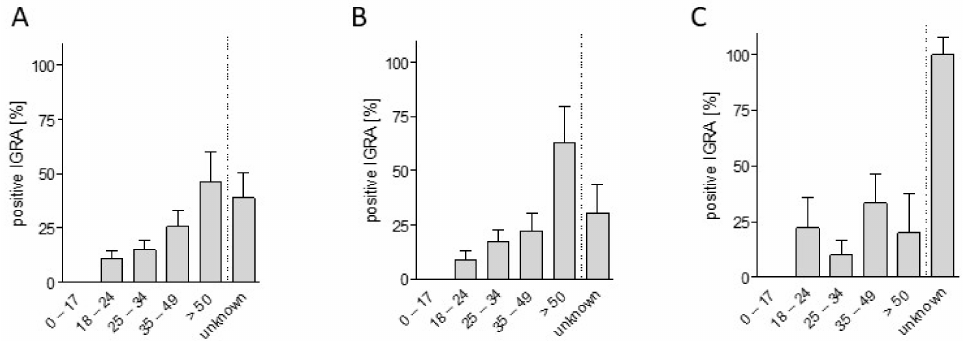
Figure 2. ( A ) Rate of positive IGRA test results in age- specific subgroups of the analyzed refugee cohort; ( B ) Age-related IGRA positivity in male and ( C ) female migrants (bars display the mean plus standard